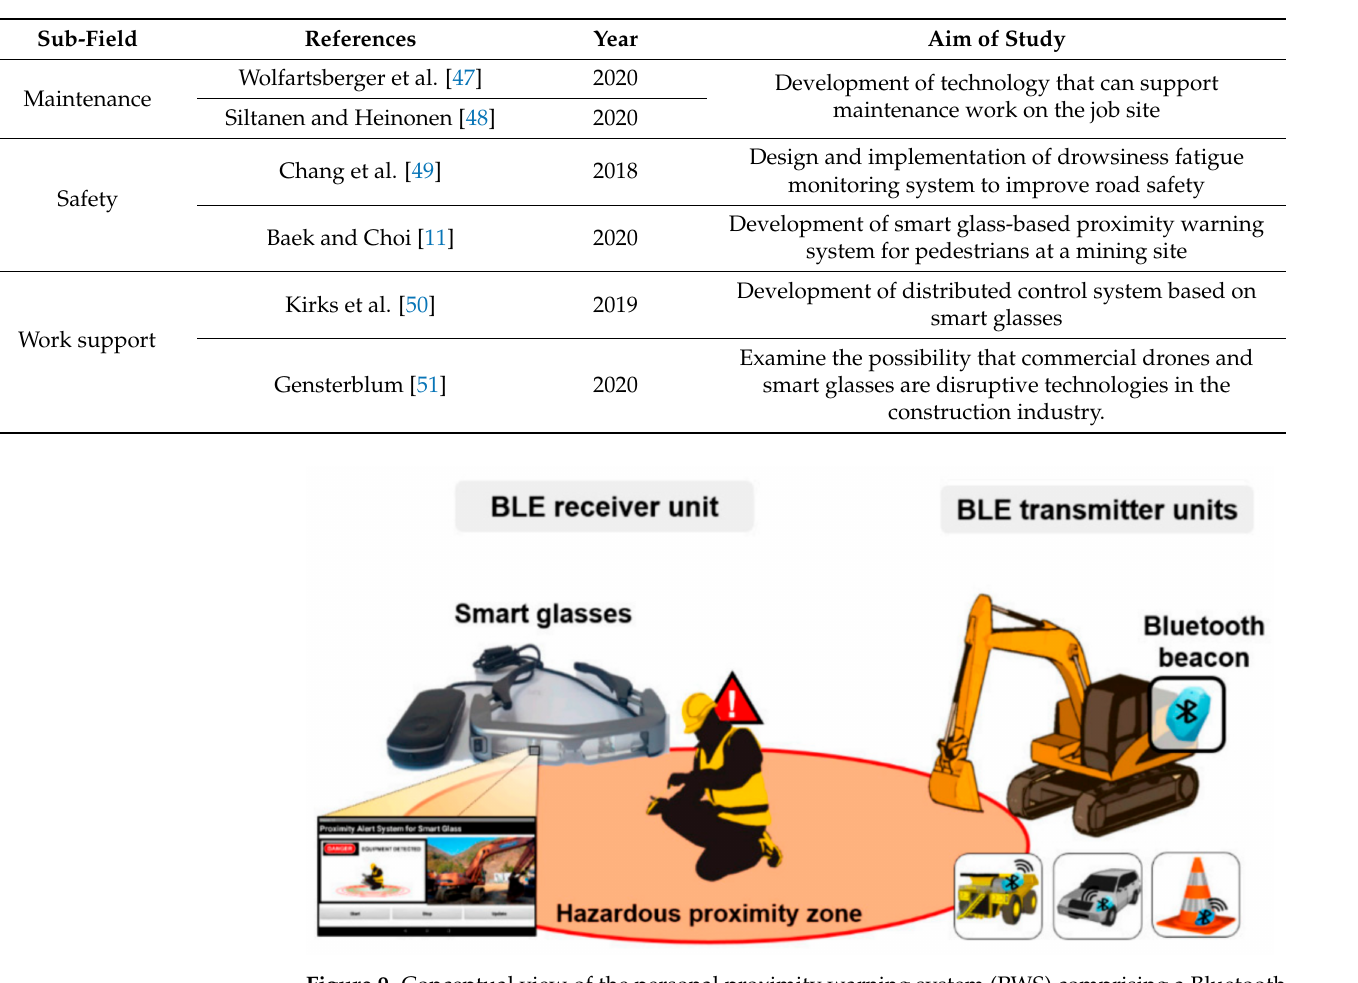
Figure 9. Conceptual view of the personal proximity warning system (PWS) comprising a Bluetooth low energy (BLE) receiver unit and BLE transmitter units